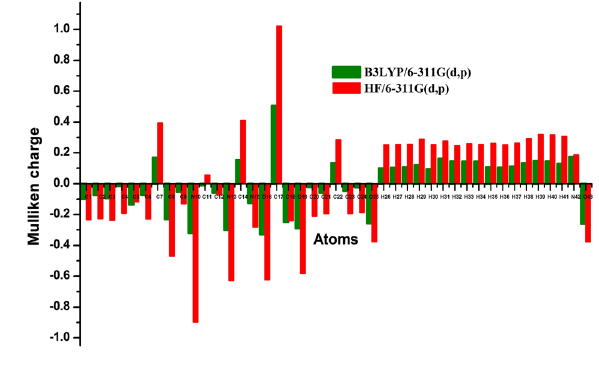
Figure 4: The Mulliken charge distribution for the IPAONM